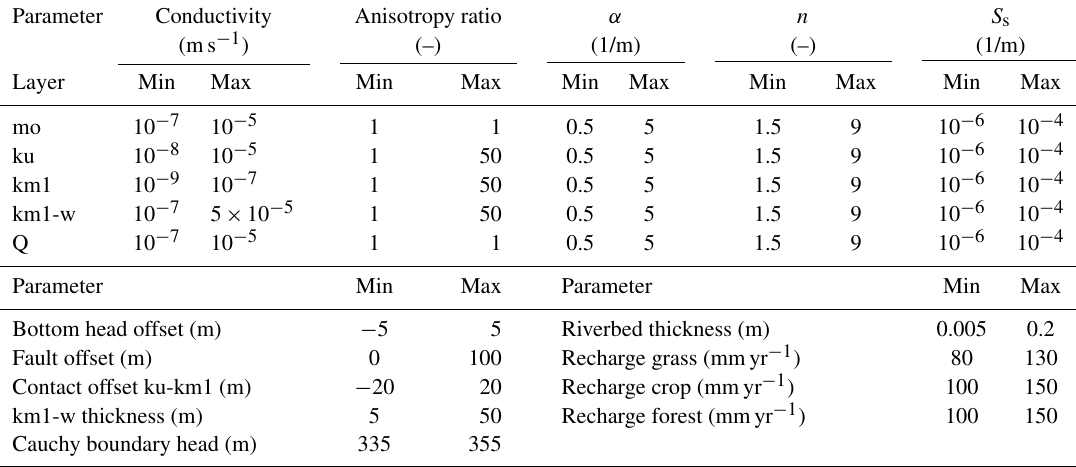
Table 1. Sampling ranges for of stochastic parameters considered.